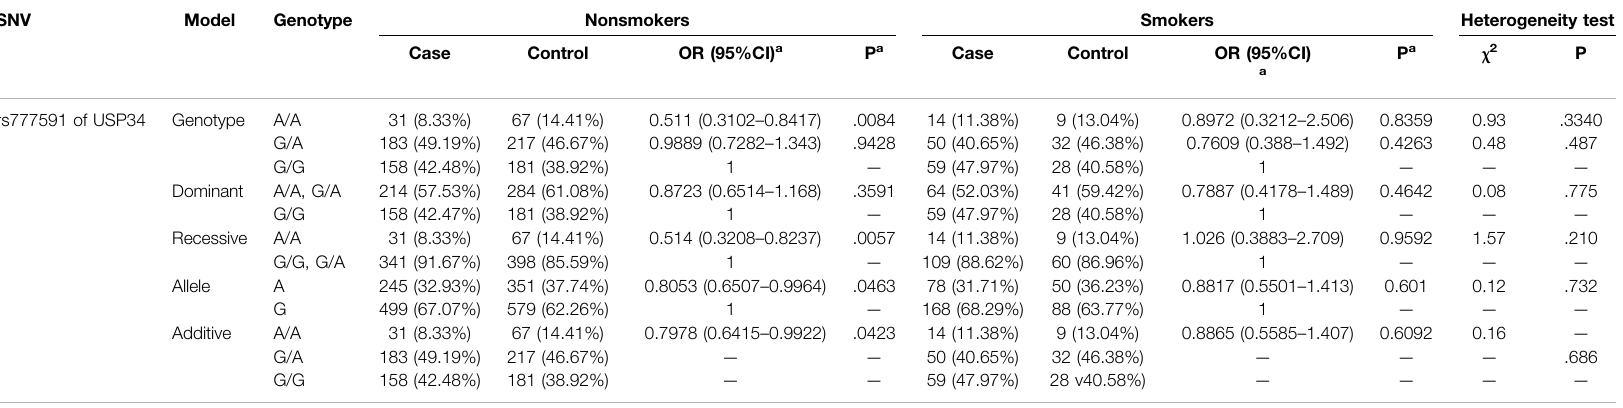
TABLE 3 | Analysis of genotypes for rs777591 of USP34 among nonsmokers and smokers.